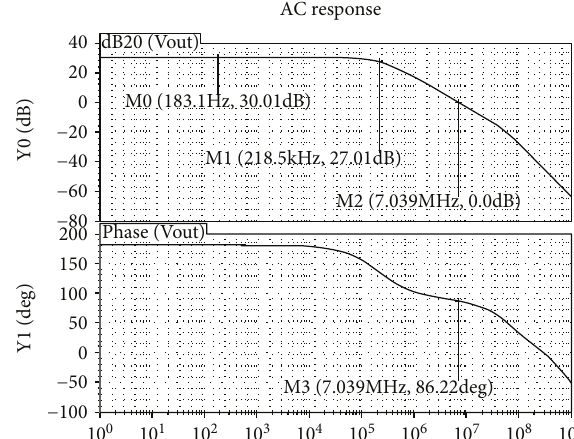
Figure 3: The designed analog multiplier.